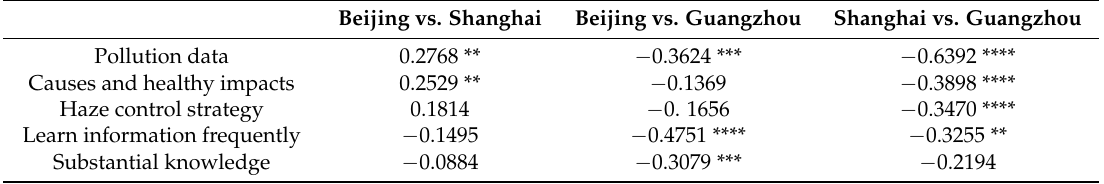
Table 12. ANOVA analysis of knowledge among Beijing, Shanghai, and